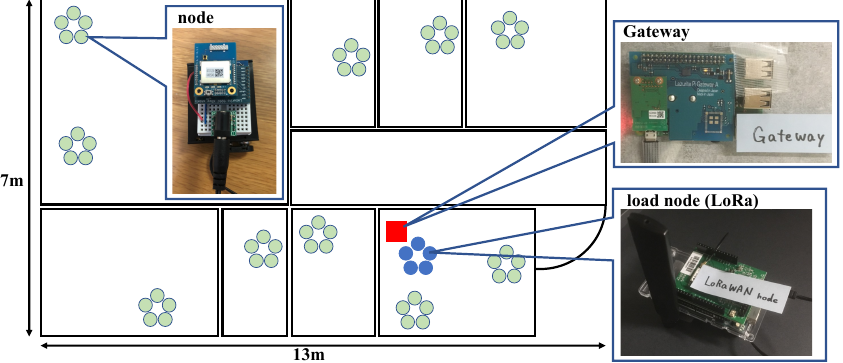
Figure 11. The layout of the IoT devices in the experiment. Table 3 summarizes the experimental